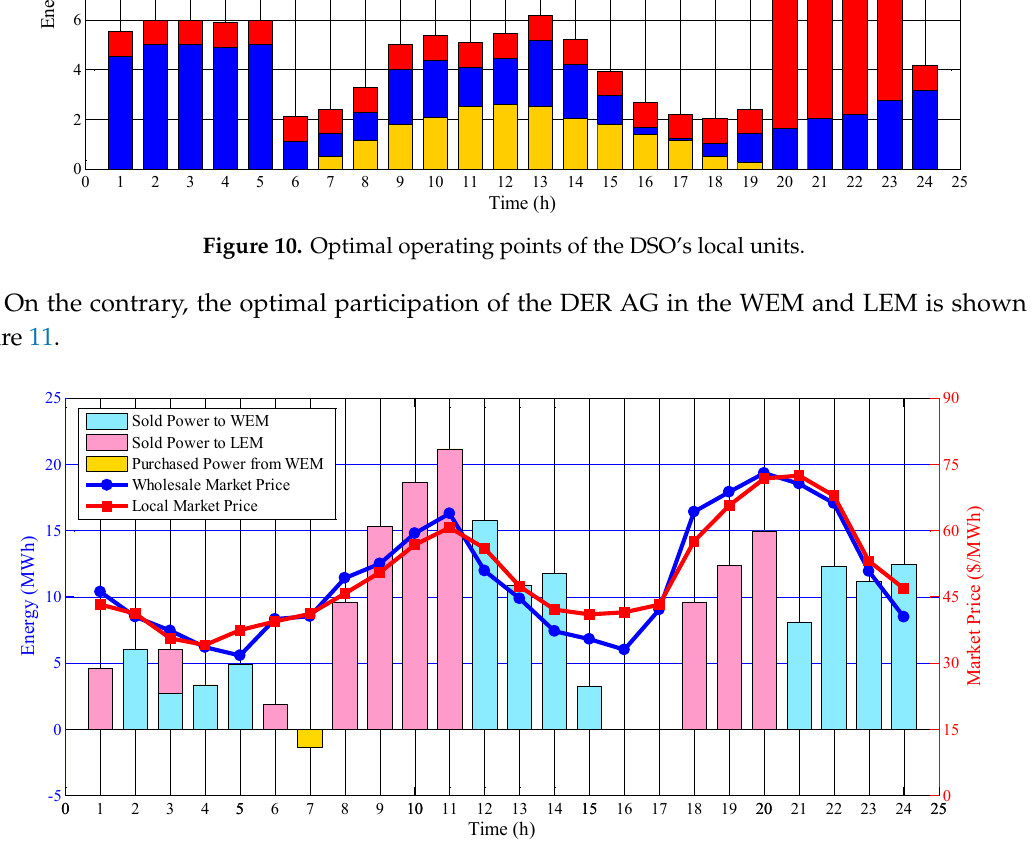
Figure 12. Optimal operating points of the AG’s local sources. As mentioned previously, in the wait-and-see phase, after the realization of stochastic variables, the aforementioned entities make their decisions as to the exchanged energy in the RT WEM and RT LEM. At this stage, optimum decisions are made according to generated scenarios. These scenarios represent the changes of uncertain parameters from the forecasted values. For the sake of clarity, the WT and PV power variations of the AG during a day and in the entire set of scenarios are displayed in Figure 13.